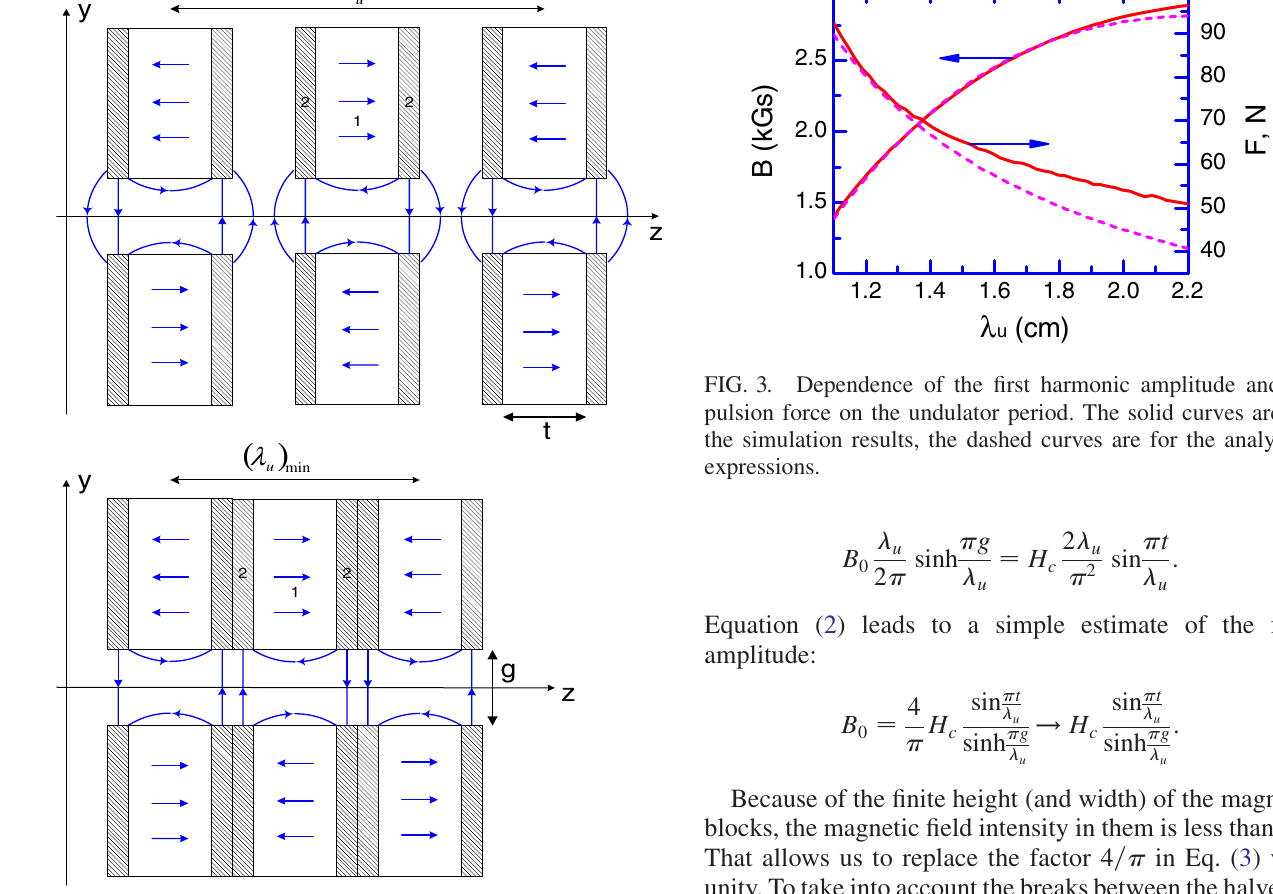
FIG. 1. The hybrid permanent magnet undulator with split poles (side view). (1) Magnet blocks. (2) Iron (or permendure). Lines of magnetic induction are shown with arrows. The lower scheme represents the minimum period, when the split-pole undulator becomes a conventional hybrid undulator.